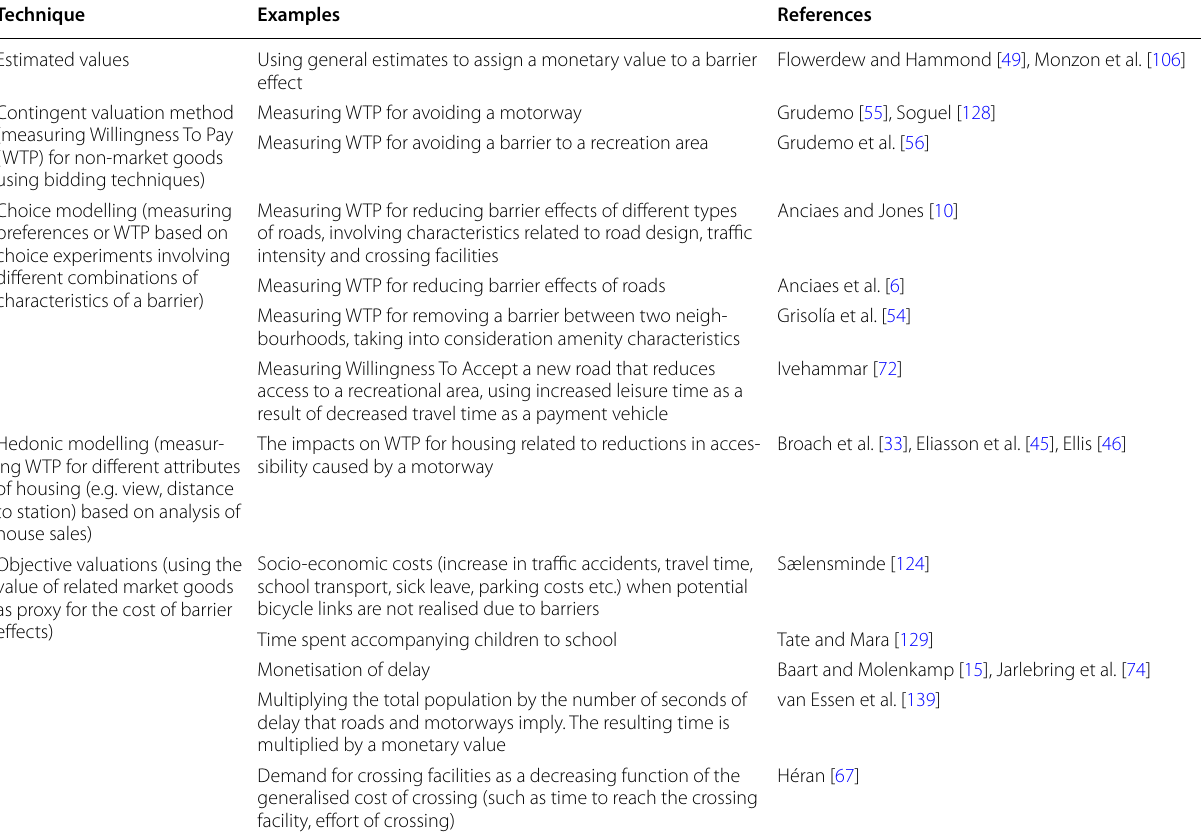
Table 10 Techniques for monetisation of barrier